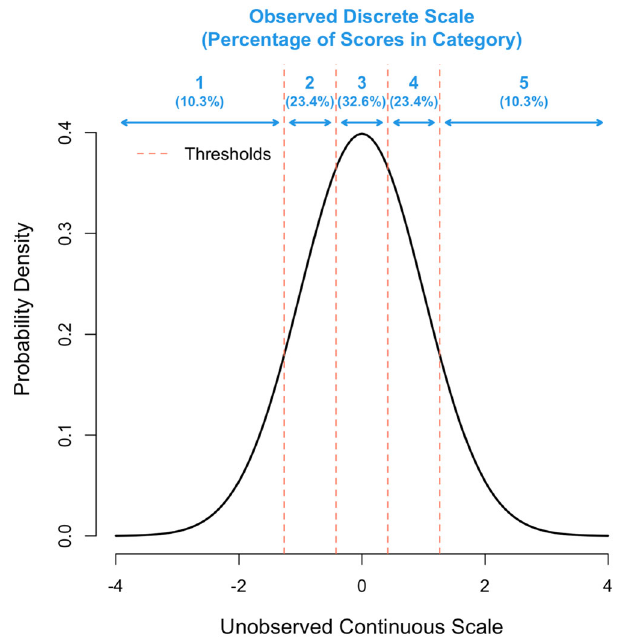
Figure 1. Representation of the multiple threshold model for k = 5 categories. The x-axis shows the unobserved continuous scale in standard deviation units and the y-axis the density. The position of each of the 4 thresholds is shown as a vertical red